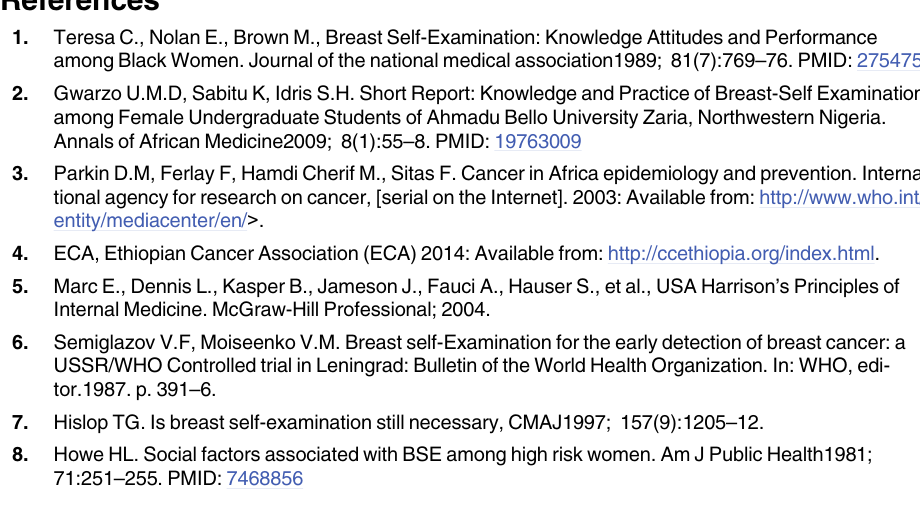
S1 Table. Socio demographic characteristics of study subjects, in Hawassa Health Science College, 2015 (N =